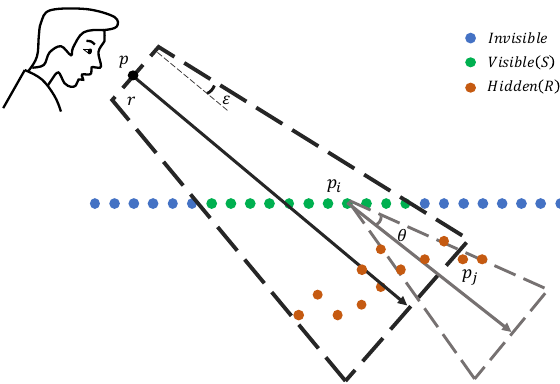
Figure 3. Occlusion detection and visual region estimation.